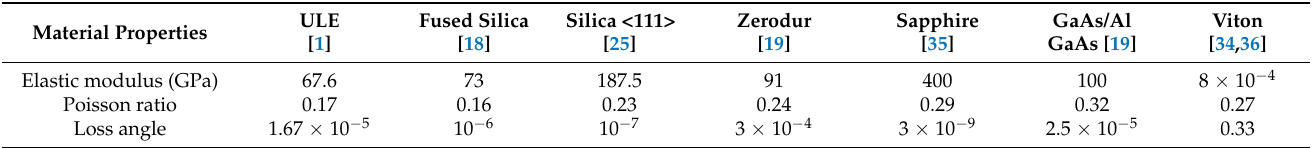
Table 2. Material properties used for the estimation and